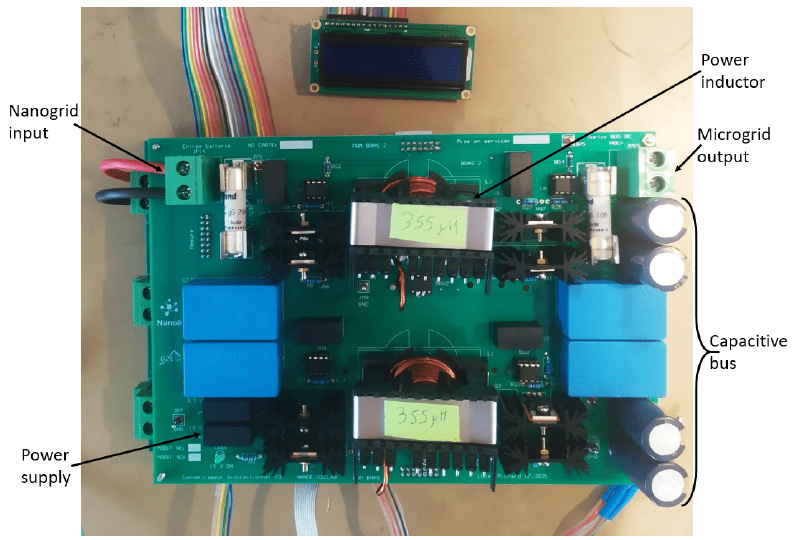
Figure 25. Power card of the interconnection module.